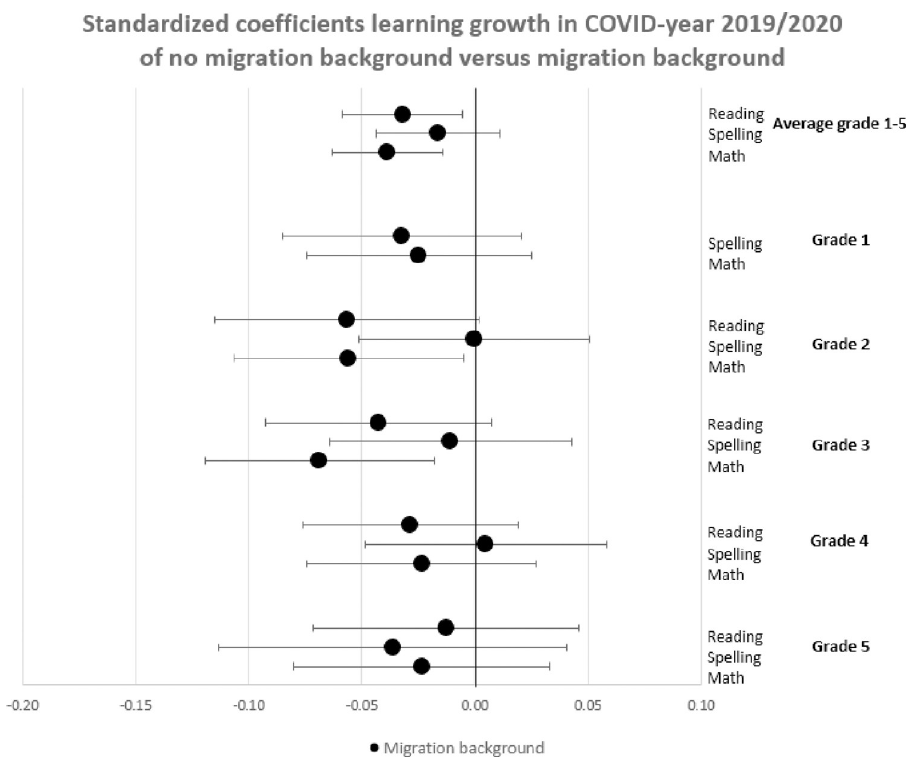
Fig 4. Standardized coefficients of learning gains in COVID-19-year 2019/2020 of no non-western migration background (zero line) versus non-western migration background.